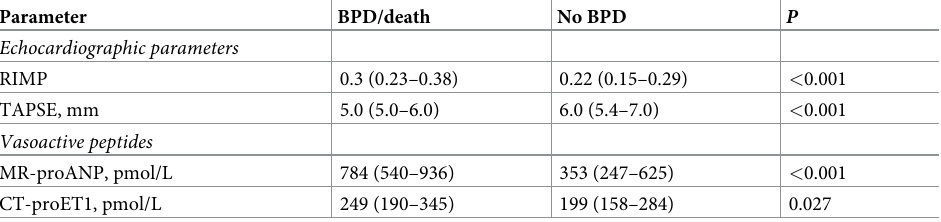
Table 2. Comparison of echocardiographic parameters and vasoactive peptides between infants with BPD/death and without